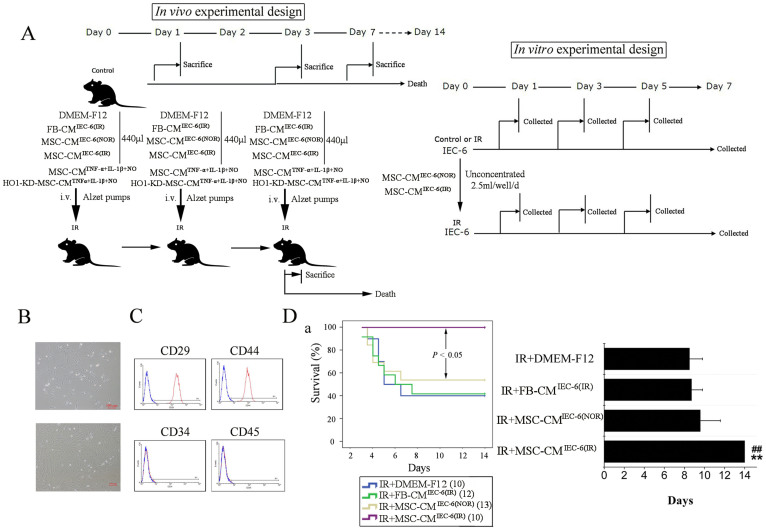
MSC-CMIEC-6(IR) improves the survival of rats exposed to 14-Gy abdominal irradiation.(A) The experimental design is depicted for in vivo and in vitro experiments (drawn by Hao Chen using Coreldraw X5 and Photoshop CS3 software). For the in vivo experiments, adult Sprague-Dawley rats were not irradiated (control) or were irradiated (IR) with 14 Gy abdominal irradiation at day O, followed by a course of i.v. injection and continuous peritoneal infusion via Alzet pump with control medium (DMEM-F12) or conditioned medium from fibroblasts activated under radiation-induced inflammatory condition (FB-CMIEC-6(IR)), non-activated MSCs (MSC-CMIEC-6(NOR)), MSCs activated under radiation-induced inflammatory condition (MSC-CMIEC-6(IR)) with or without neutralizing antibodies (NAs), MSCs activated by TNF-α, IL-1β and NO donor (MSC-CMTNF-α + IL-1β + NO) and HO-1-knockdown MSCs activated by TNF-α, IL-1β and NO donor (HO1-KD-MSC-CMTNF-α + IL-1β + NO). Rats were either sacrificed at 1, 3, 7 days for structural and functional examination or were monitored for survival status throughout the 14 day course of the experiment. For in vitro experiments, control rat intestinal epithelial IEC-6 cells or cells irradiated with 10 Gy were cultured for 7 days. In parallel, irradiated IEC-6 cells were co-cultured in six-well plates with unconcentrated MSC-CMIEC-6(NOR) or MSC-CMIEC-6(IR) with or without neutralizing antibodies, and the proliferation and apoptosis were evaluated every other day as shown. (B) Morphological features of BM-MSCs. (upper panel) Spindle-shaped morphology of primary BM-MSCs at day 3. (lower panel) More confluent BM-MSCs at passage 2. (C) Flow cytometric characterization of BM-MSCs. BM-MSCs (red) expressed CD29 (99.17 ± 1.36%) and CD44 (98.24 ± 1.01%) but not CD34 (2.79 ± 0.24%) and CD45 (1.69 ± 0.19%). (D) MSC-CMIEC-6(IR) improves the survival rates and lengthens the survival time of rats following 14 Gy abdominal irradiation. (left panel) Cumulative survival for irradiated rats infused with DMEM-F12, FB-CMIEC-6(IR), MSC-CMIEC-6(NOR) or MSC-CMIEC-6(IR) was analyzed using the Kaplan-Meier method. The cumulated number of rats in each experimental group is presented in parenthesis. P-values were determined by log-rank testing. (right panel) Mean survival time. Data represent the mean ± SD. **, P < 0.05 versus IR + DMEM-F12 and IR + FB-CMIEC-6(IR). ##, P < 0.05 versus IR + MSC-CMIEC-6(NOR).